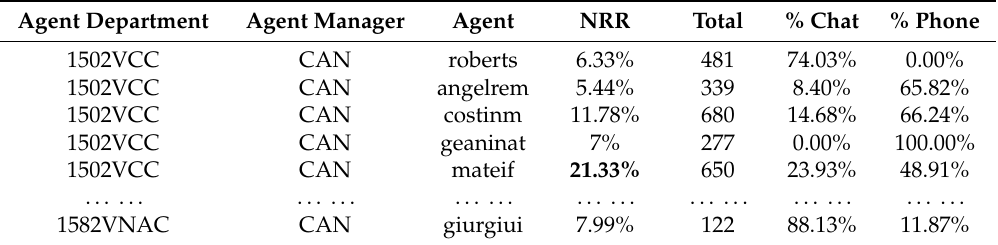
Source: Data collected from the